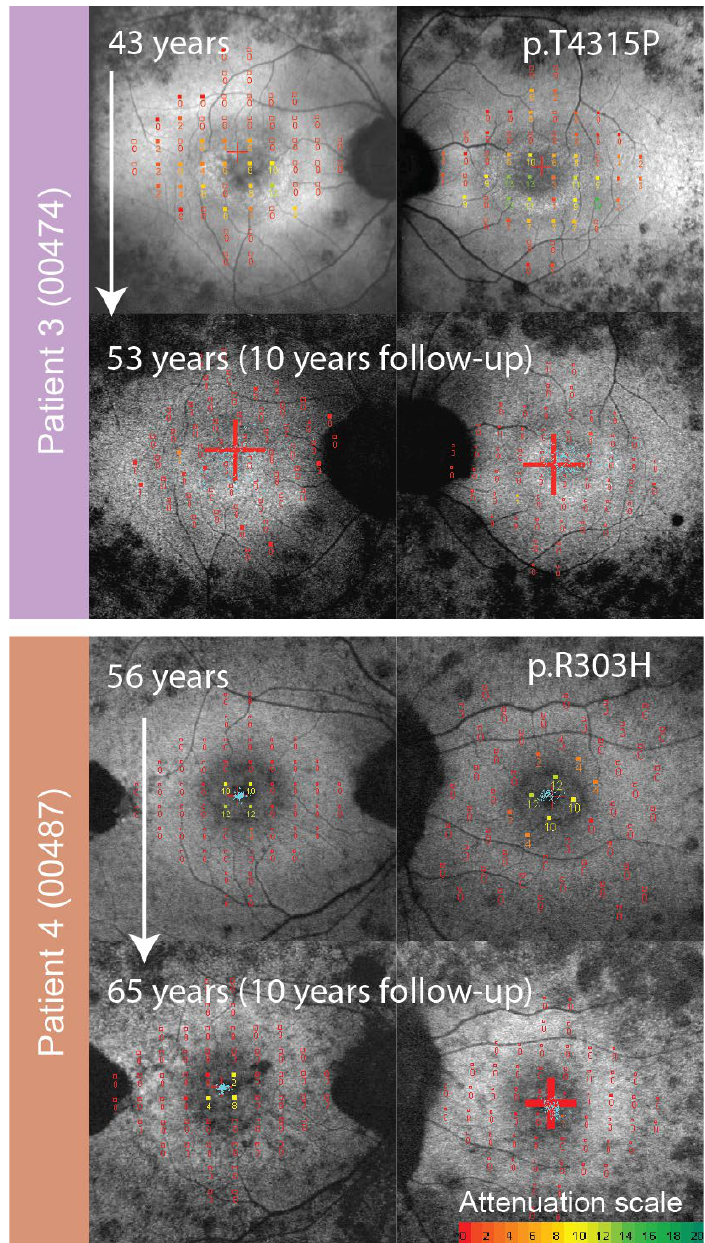
Figure 8. Enlarged FAF with overlaid microperimetry of patients who had p.(Cys870*) in trans with a missense allele. The right eye is shown on the left and the left eye on the right for each patient. Patient ID (center ID) is stated on the left side. Follow-up images are shown for both patients. Microperimetry results are on a color scale from good sensitivity (green) to poor retinal sensitivity (red), with the attenuation scale in dB shown below. Note the relatively well preserved central retinal function in Patient 4 harboring p.(Arg303His) in comparison to patients with two stop alleles of a similar age (Figure